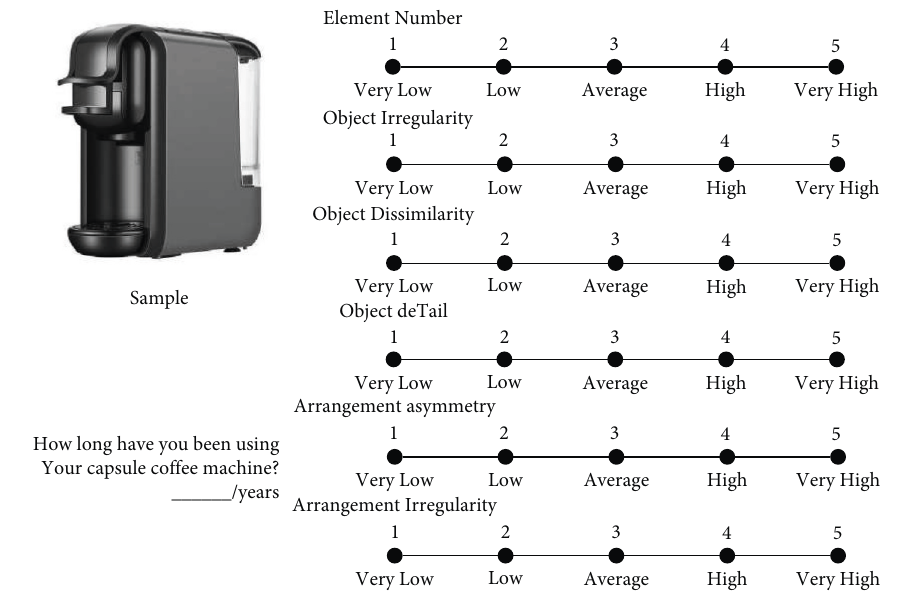
Figure 6: Questionnaire format used in the